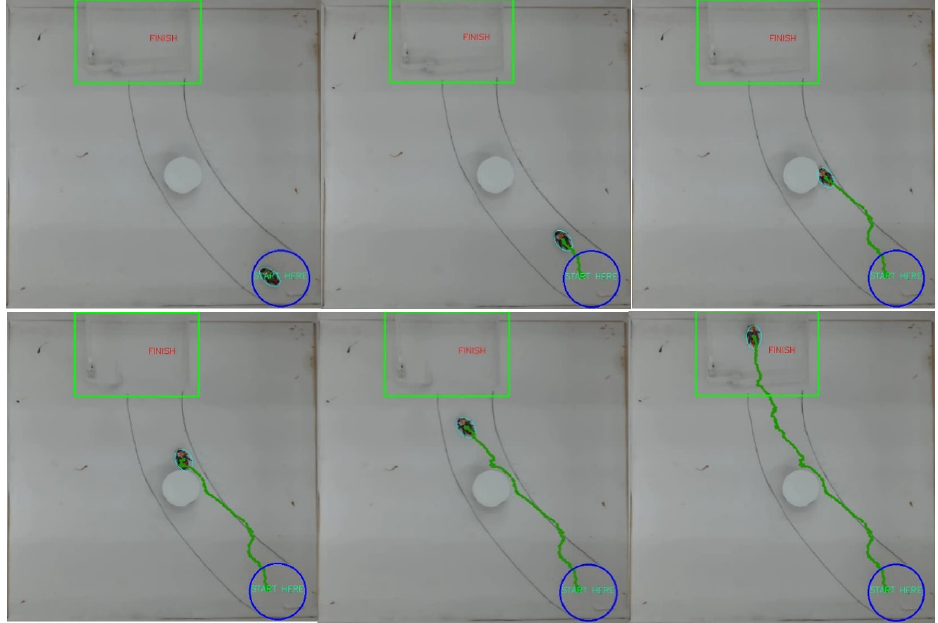
Figure 13. Sequence photos of the cockroach position response for path following trajectory com- manded from Bangladesh.